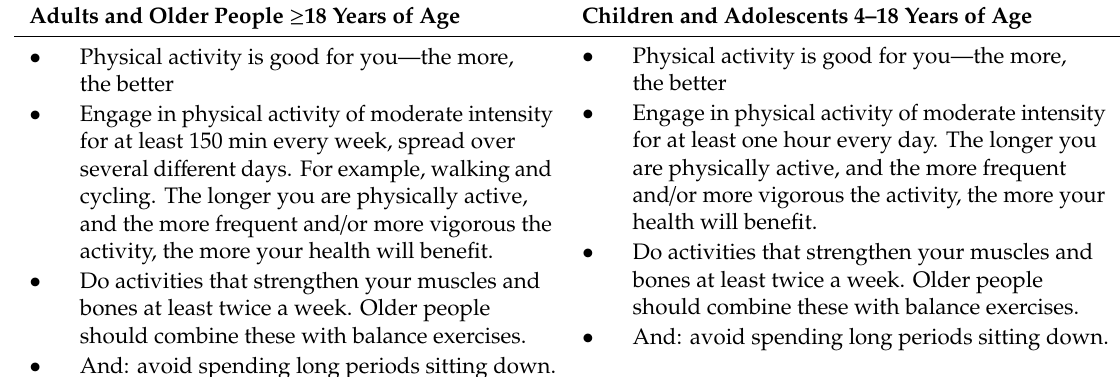
Table 1. Dutch physical activity guidelines 2017